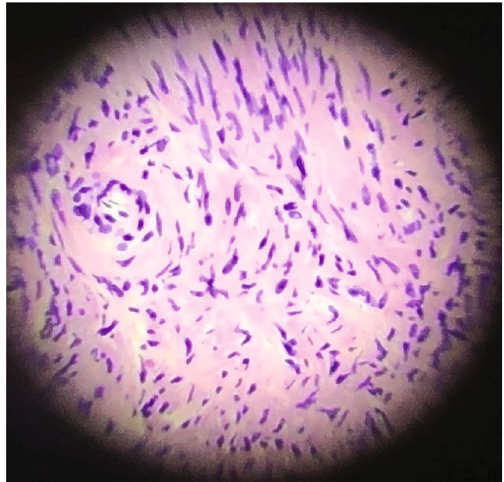
Figure 5: Microscopy of the paracolpal tumor: